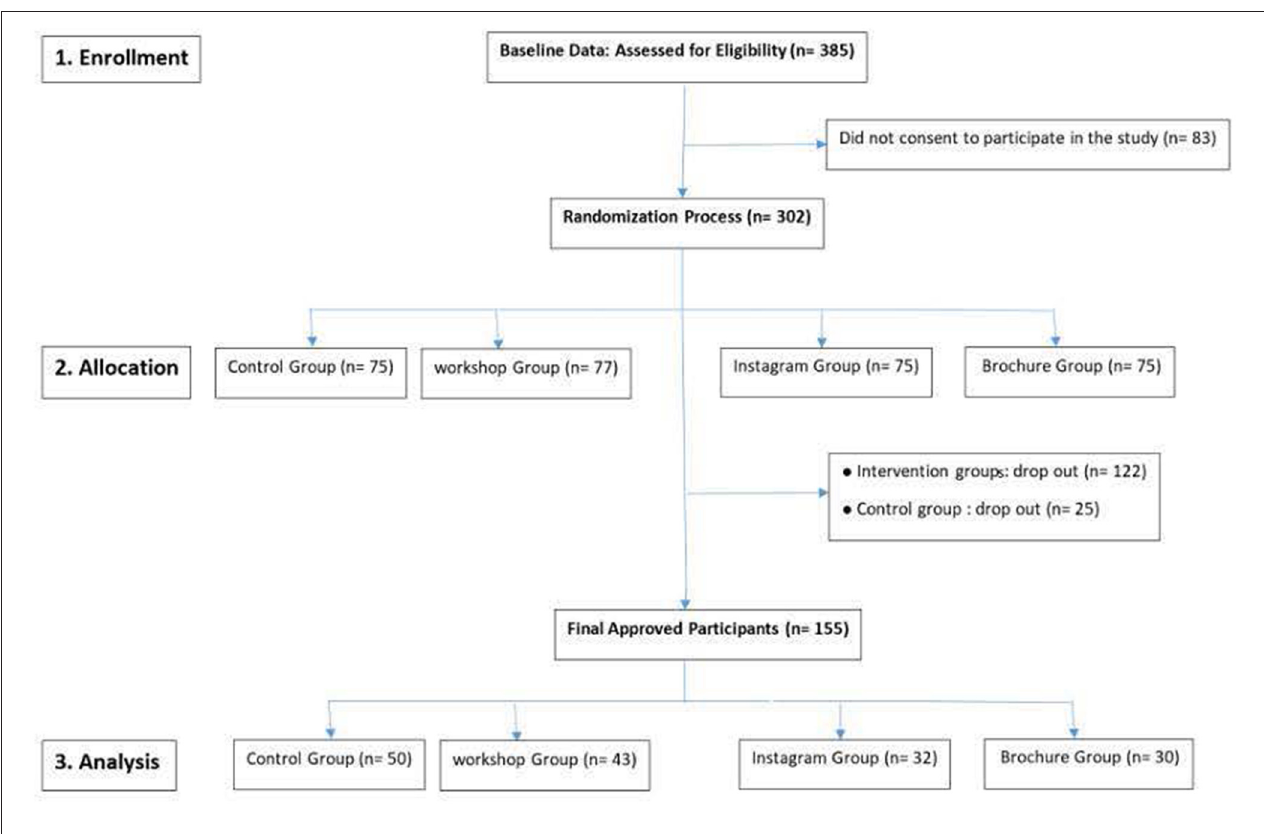
FIGURE 1 | Study flow diagram. TABLE 2 | Reliability analysis of the HLPS and its subscales ( N =